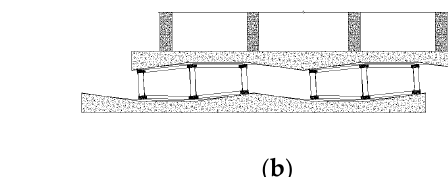
Figure 2. Cross-sectional view of super-large displacement translation friction pendulum bearing ( a ) without deformation and ( b ) with deformation.